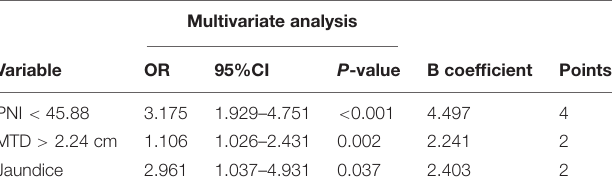
TABLE 3 | Multivariable analysis of risk factors of poor prognosis and measurement of the risk score. Multivariate